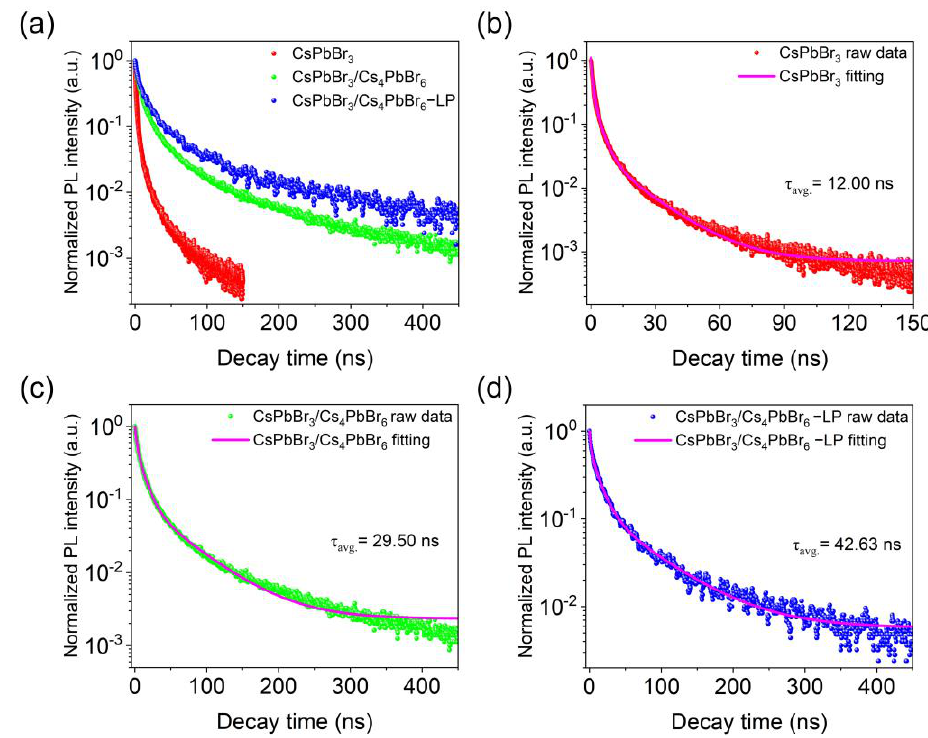
Figure 5. ( a ) The time-resolved PL decay curves of the CsPbBr 3 /Cs 4 PbBr 6 –LP microcrystals, CsPbBr 3 / Cs 4 PbBr 6 microcrystals, and pure CsPbBr 3 QD powders. PL decay fitting curves of ( b ) pure CsPbBr 3